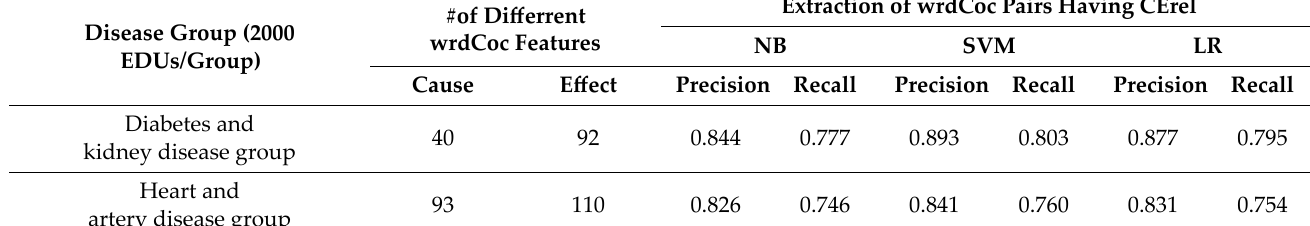
Table 3. The accuracy of determining wrdCoc pairs having CErel.